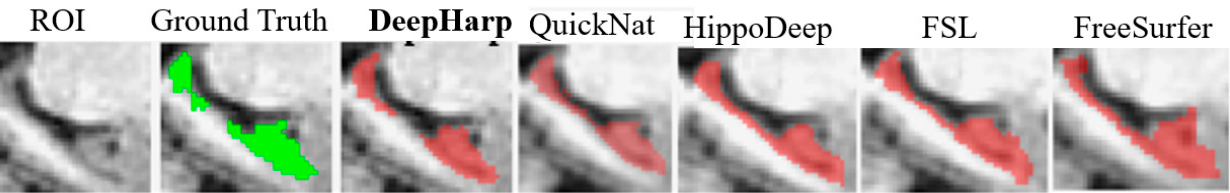
Sensors 2021 , 21 , x FOR PEER REVIEW Figure 5. Segmentation accuracy of DeepHarp and the other four tools on the test set.